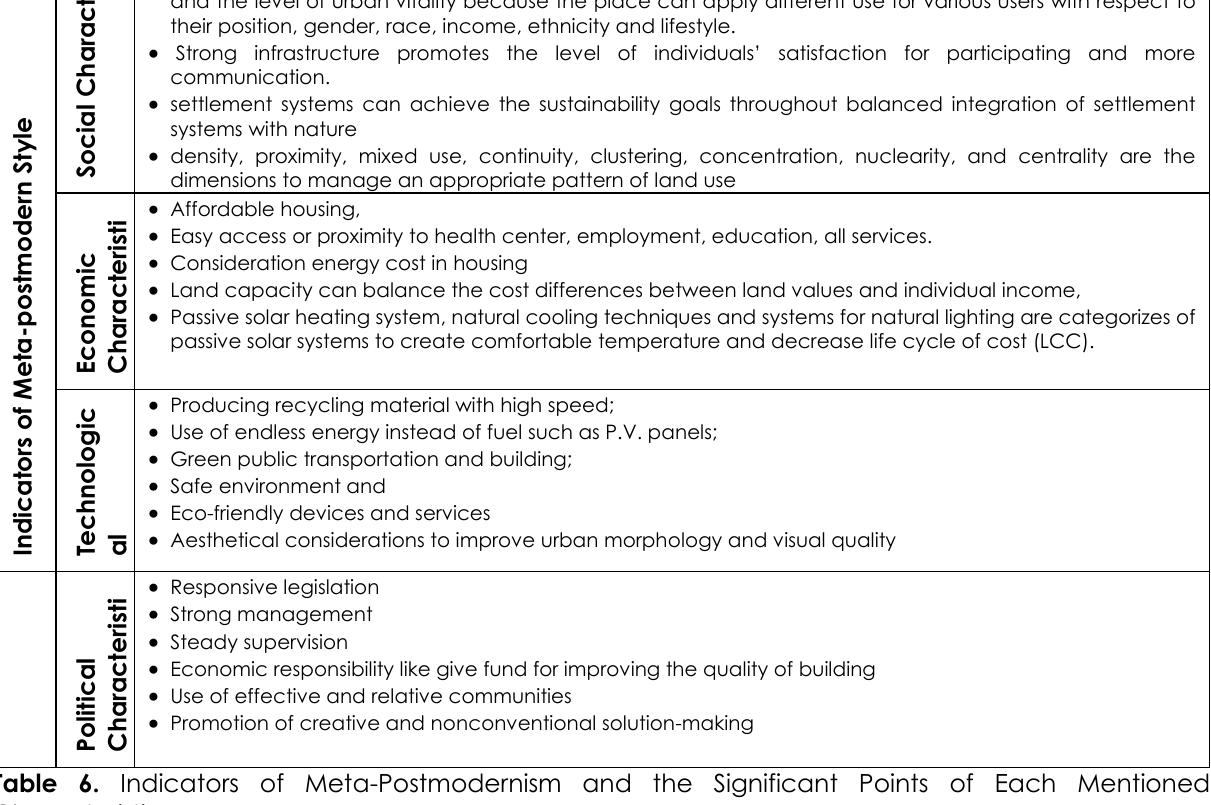
Table 6. Indicators of Meta-Postmodernism and the Significant Points of Each Mentioned